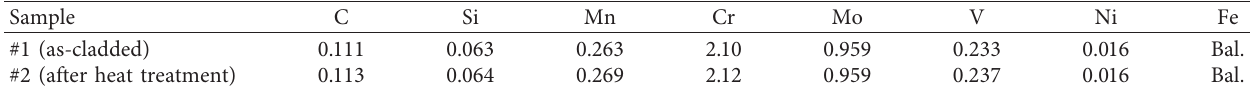
Table 3: Chemical composition (wt%) of the 2.25Cr1Mo0.25V sample made by WAAM.